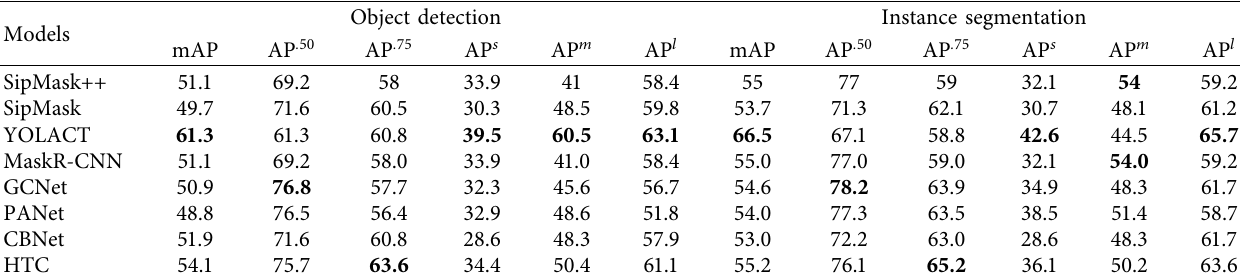
Table 2: A performance comparison ranking with the DSMLR dataset and the performance reported in Pasupa et al. [60] against the algorithms reported in this study SipMask++, YOLACT-550, SipMask, and YOLACT.